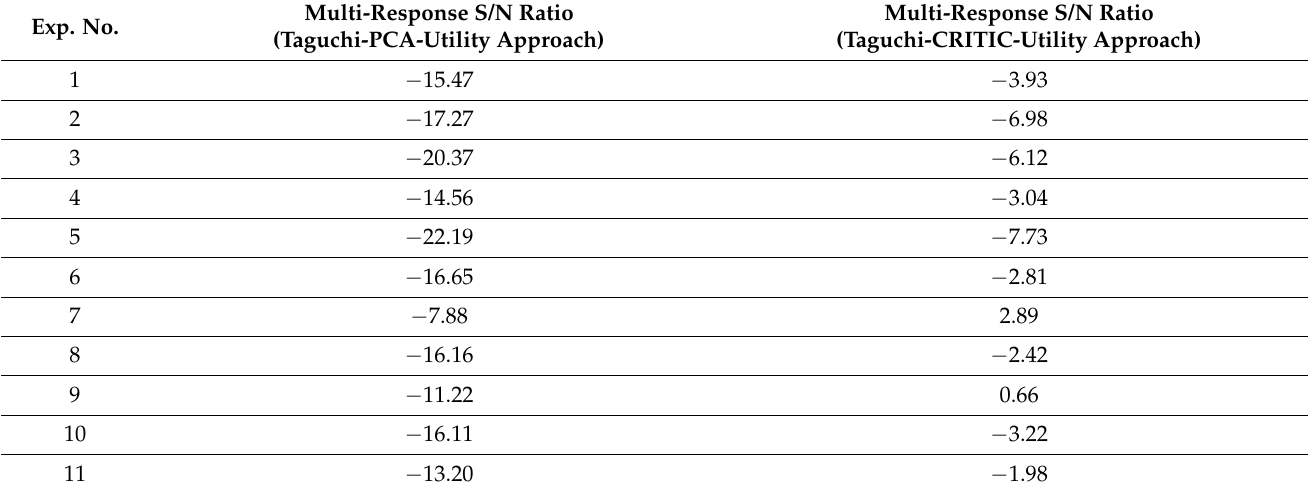
Table 15. Multi-response S/N ratio of hybrid